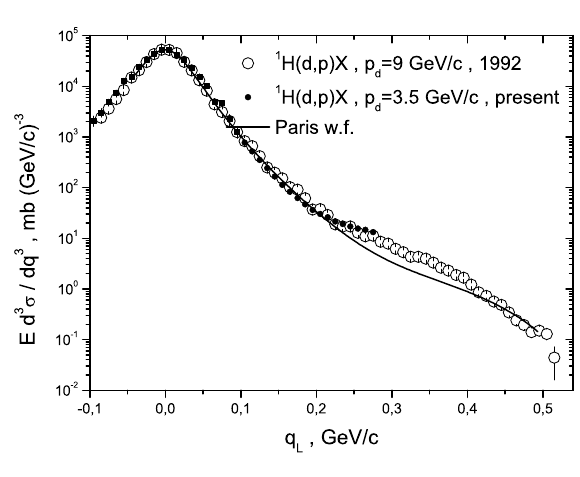
Figure 1. Invariant di ff erential cross-section 1 H ( d , p ) X